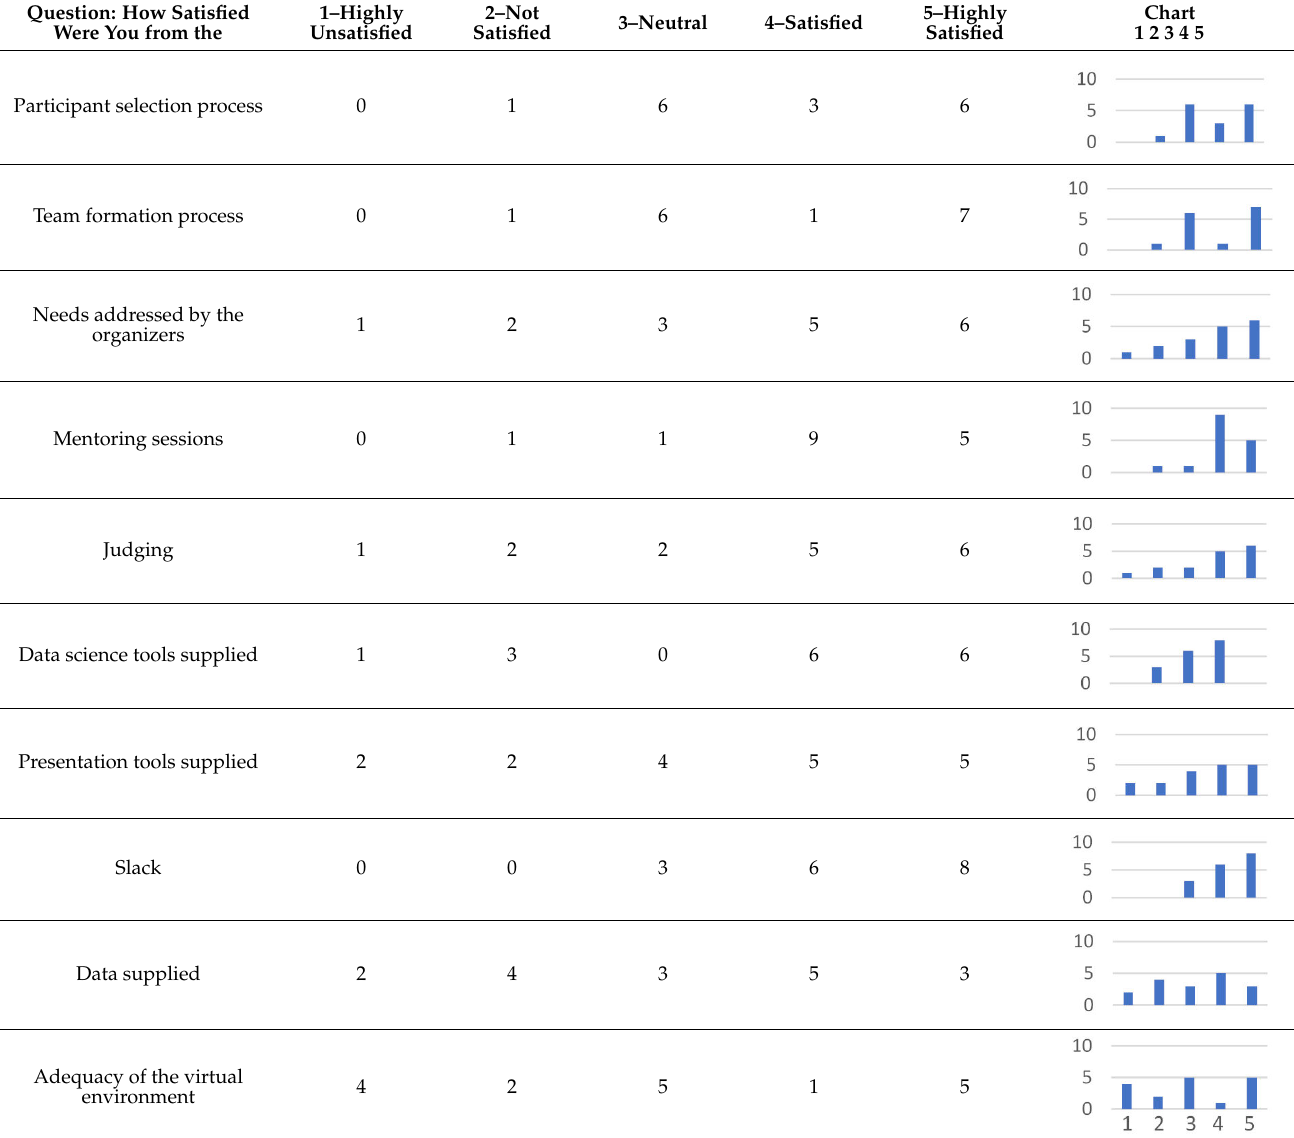
Table 4. Participants’ responses to survey questions regarding satisfaction of the Datathon. A bar chart on the right visualizes the